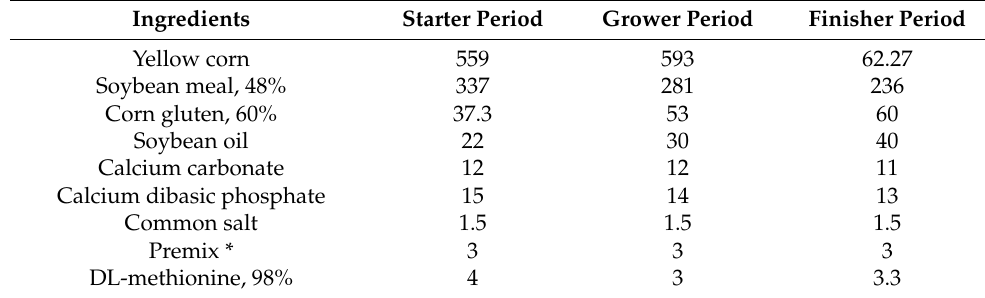
Table 1. The proximate chemical composition of the basal diet as fed basis (g Kg − 1 ).